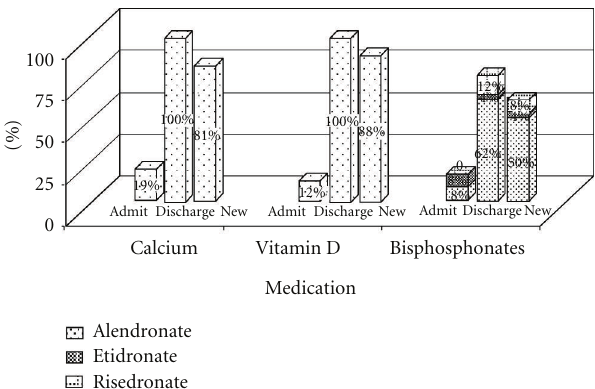
Figure 4: Medication at admission, discharge, and new prescrip- tions in GAU